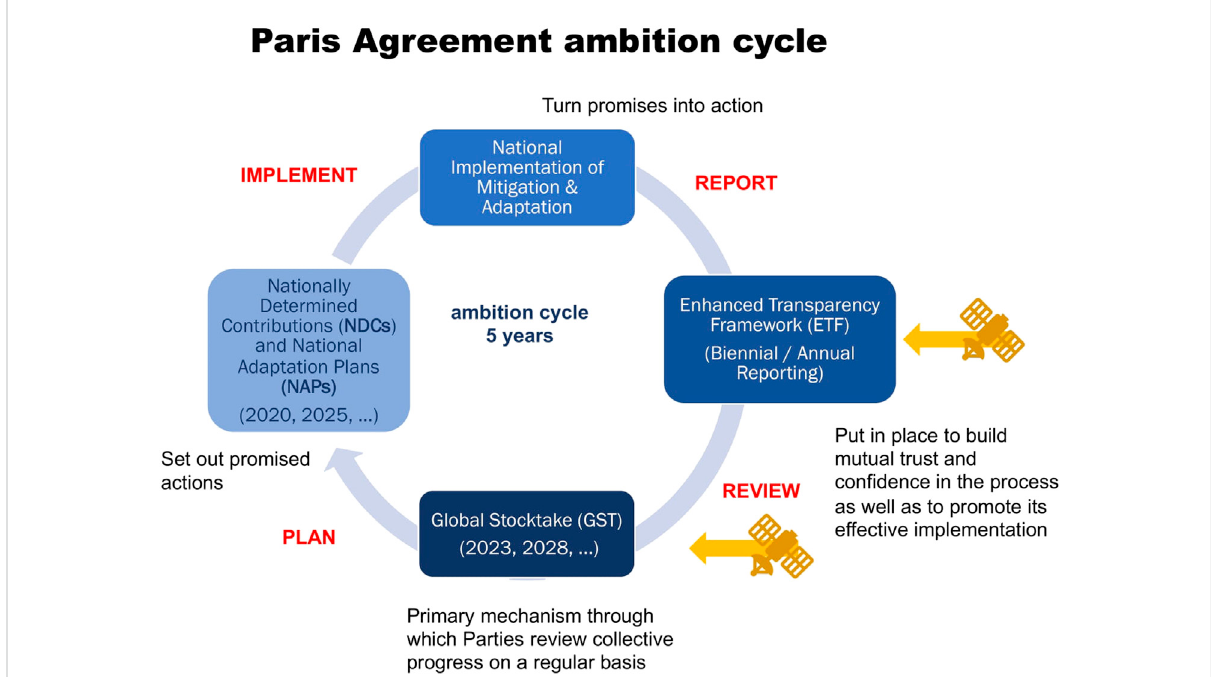
FIGURE 3 TheUNFCCCParisAgreement ’ sambitioncycle,whichaimsatstrengtheningthecommitmentoftheworld ’ snationstocombatclimatechange withde fi nedmilestonesthatrepeatevery5 years.TheETFprovidesguidelinestocountriesonreportingofGHGemissionsandthusprogresstoward NDCs,onadaptationtoclimatechangeimpactsandthusprogressonNAPs,andonbothprovidedandreceived fi nancialsupport(nottreatedfurther here) in documents known as Biennial Transparency Reports (BTRs). The ETF also aims at providing streamlined information for use in the GST. EO can help support the ETF inboth the national reporting and global reviewing tasks (yellow arrows and satellite symbols). Adaptedfrom Figure1 in UNFCCC Climate Change Secretariat